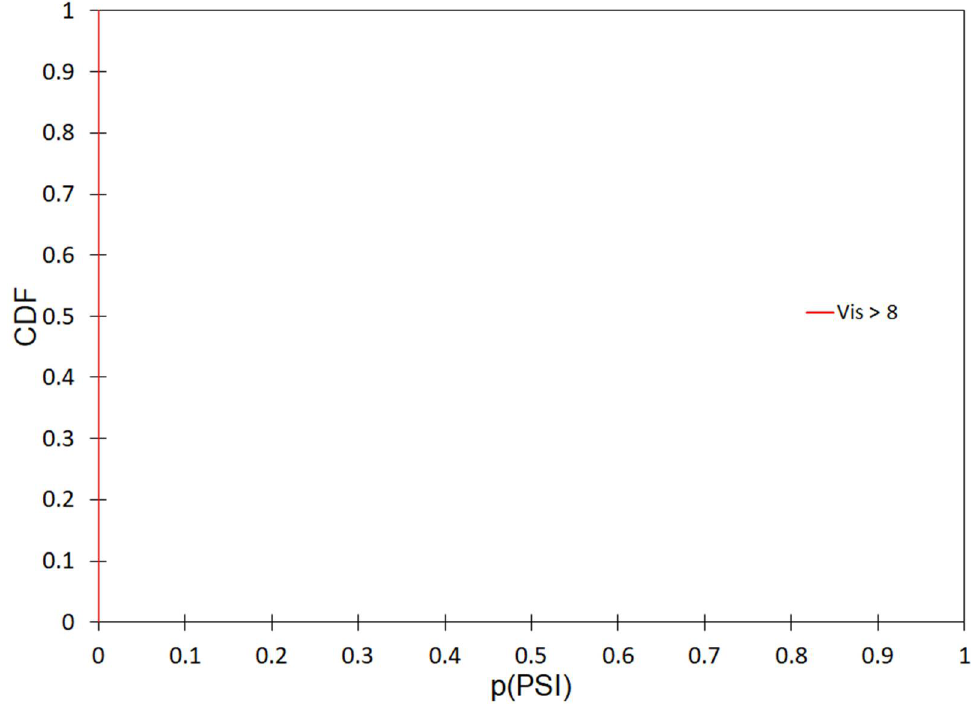
Figure A23. Effect of visibility on the incidence of very high summer mortality for rainy days.